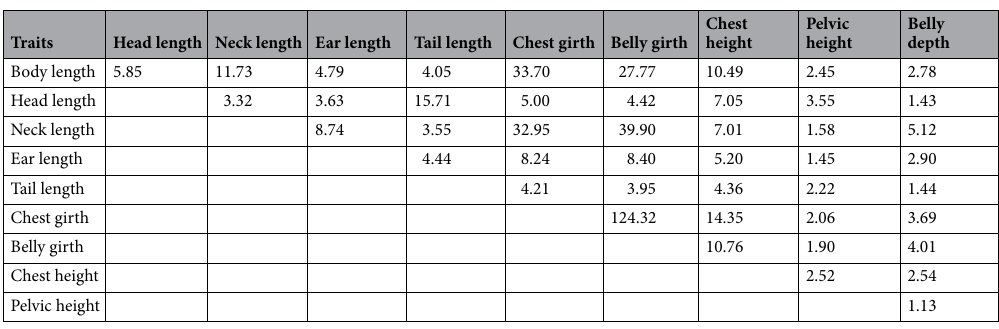
Table 3. Variance inflation factors (VIF) for the relationships between body dimensions (cm) of Dorcas gazelle.